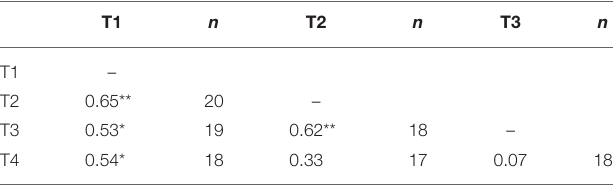
TABLE 5 | Correlations of procrastination scores over time: control group.